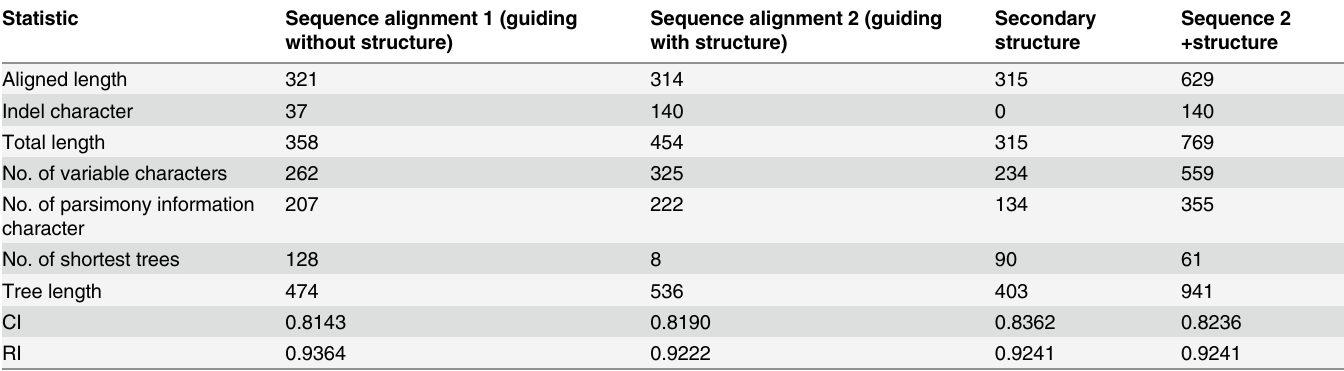
Table 2. Statistics of phylogenetic analysis from different alignments. Statistic Sequence alignment 1 (guiding